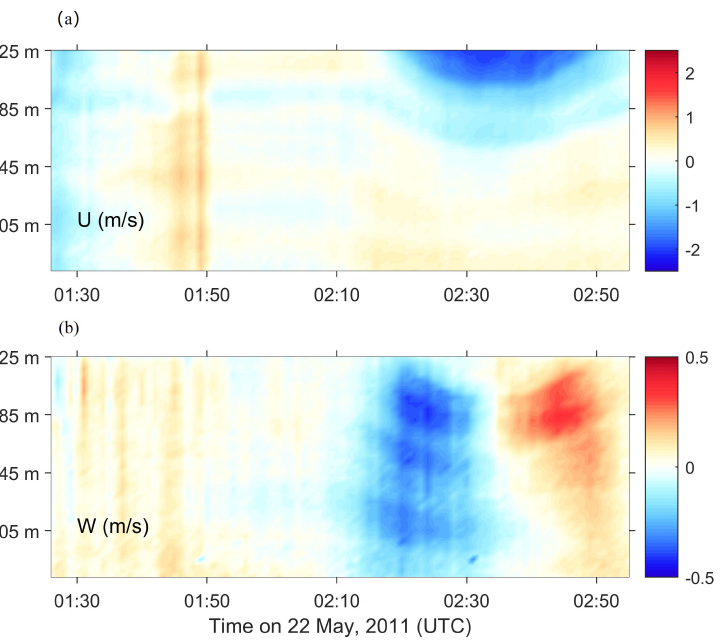
Figure 4. Current velocity profiles of the trailing wave. ( a ) Zonal current velocity; ( b ) vertical current velocity.